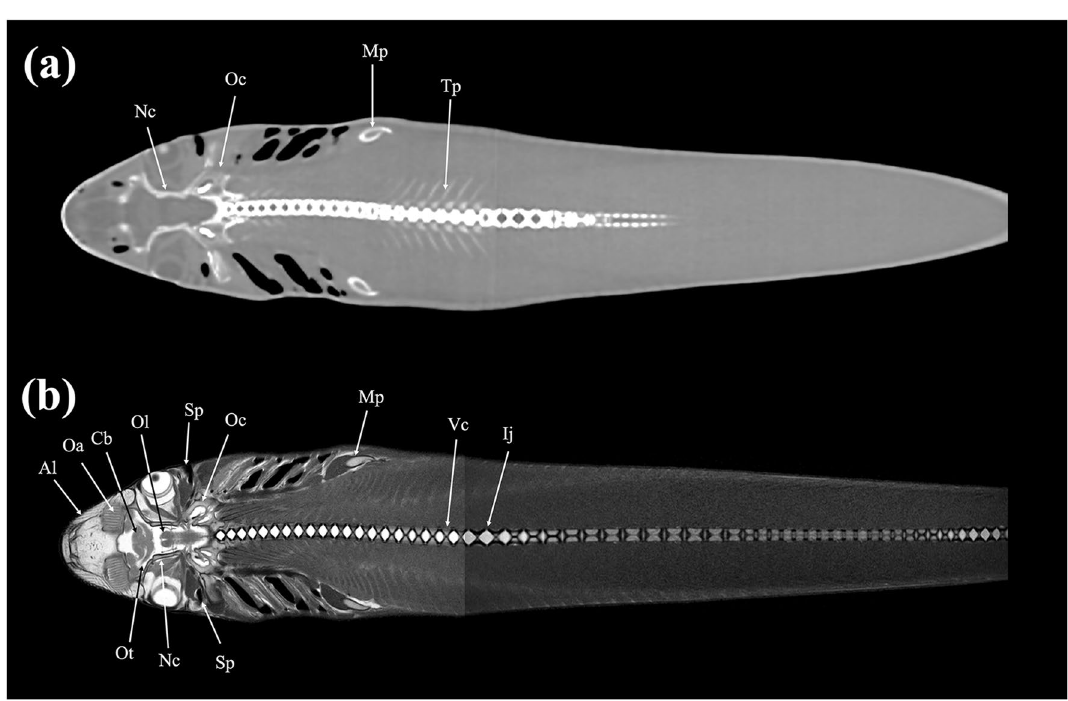
Figure 19. Dorsal ( a ) CT and ( b ) MR images of a banded houndshark ( Triakis scyllium ) at level 19 of Fig. 25. Al Ampullae of Lorenzini, Cb Cerebrum, Ij Intervertebral junction, Mp Metapterygium, Nc Neurocranium, Oa Olfactory lamellae, Oc Otic capsule, Ol Optic lobe, Ot Olfactory tract, Sp Spiracle, Tp Transverse process, Vc Vertebral